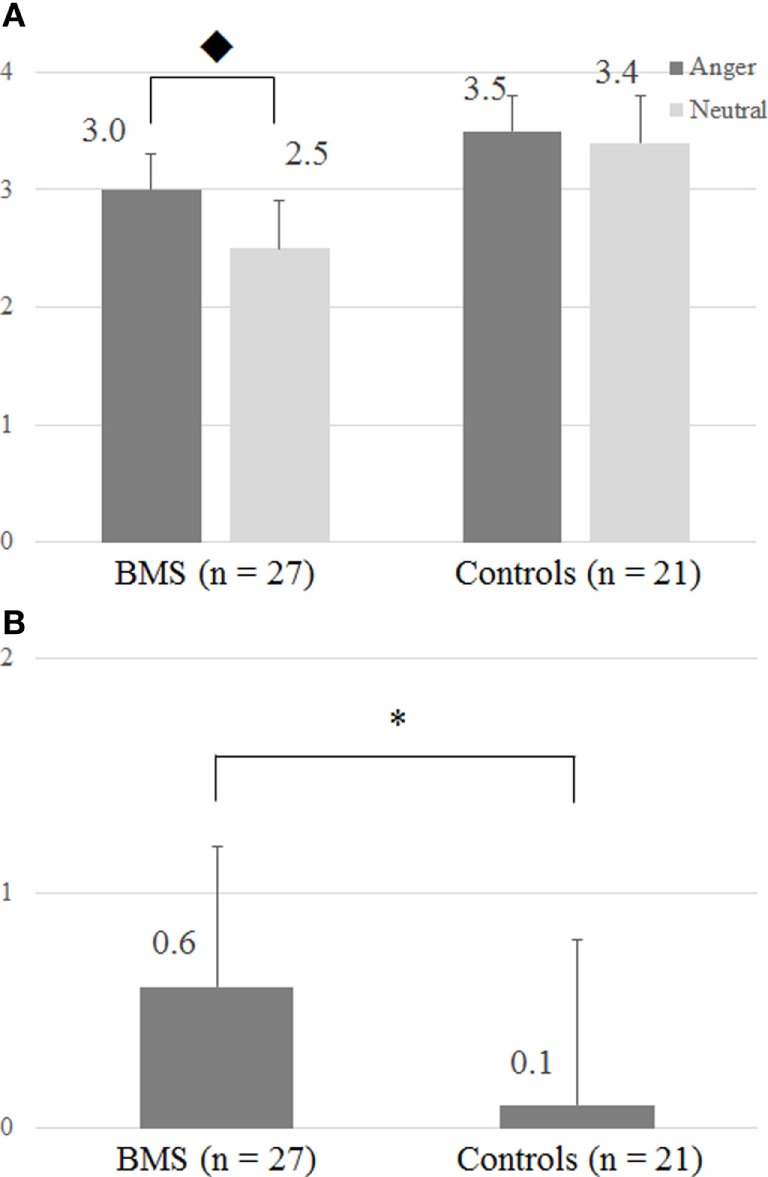
(A) Intensity of tactile perception by the differences of facial images. (B) Anger-specific tactile rating scores. The y-axis in panels (A,B), respectively, represents a numeric rating scale (NRS) rating score and an anger-specific tactile rating score which was defined by subtracting NRS rating scores in the neutral condition from the angry condition. ◆ The two-way ANOVA (Group × Emotion) revealed significant interactions (F1, 46 = 4.56; p < 0.05). In patients, ratings in the tactile anger condition differed significantly from those in the neutral condition (Bonferroni post hoc t test, p = 0.05). Anger-specific tactile rating scores were defined by subtracting rating scores in the neutral condition from the angry condition. *p < 0.05 (two-sample t test).